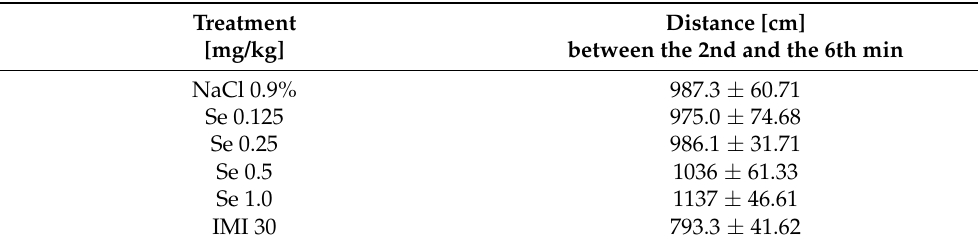
Table 1. Effect of sodium selenite on mice spontaneous locomotor activity.